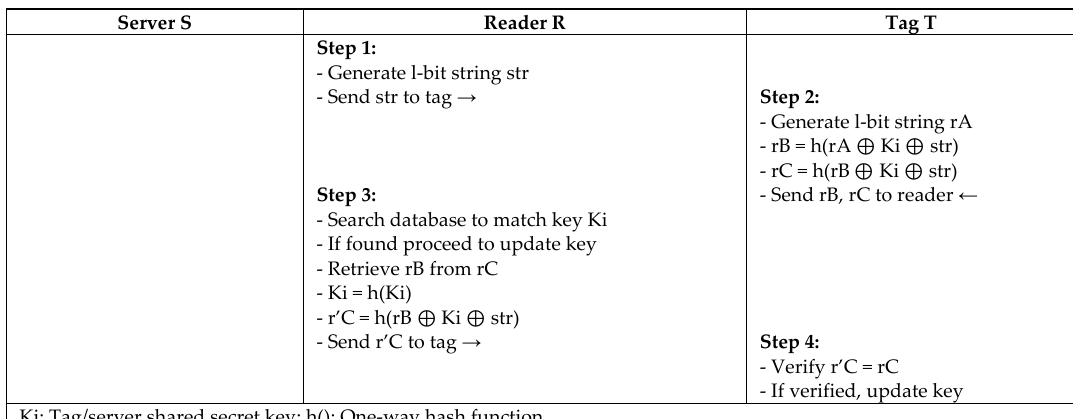
Figure 11. Flyweight Mutual Authentication Protocol by Burmeter and Munilla.